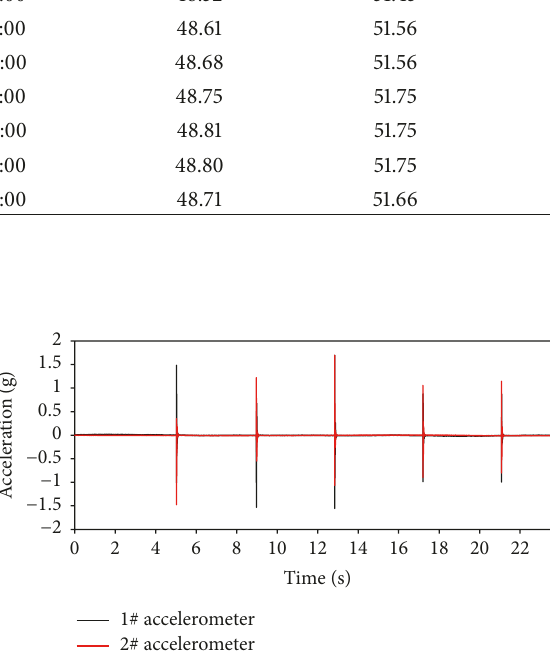
Figure 12: Acceleration time-history curves on 18 September 2016 at 8:00